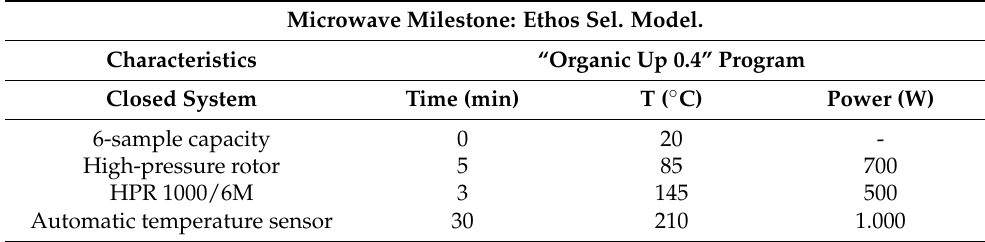
Table 2. Characteristics of the Microwave Milestone (Ethos Sel. Model) and “organic up 0.4” program. Microwave Milestone: Ethos Sel.